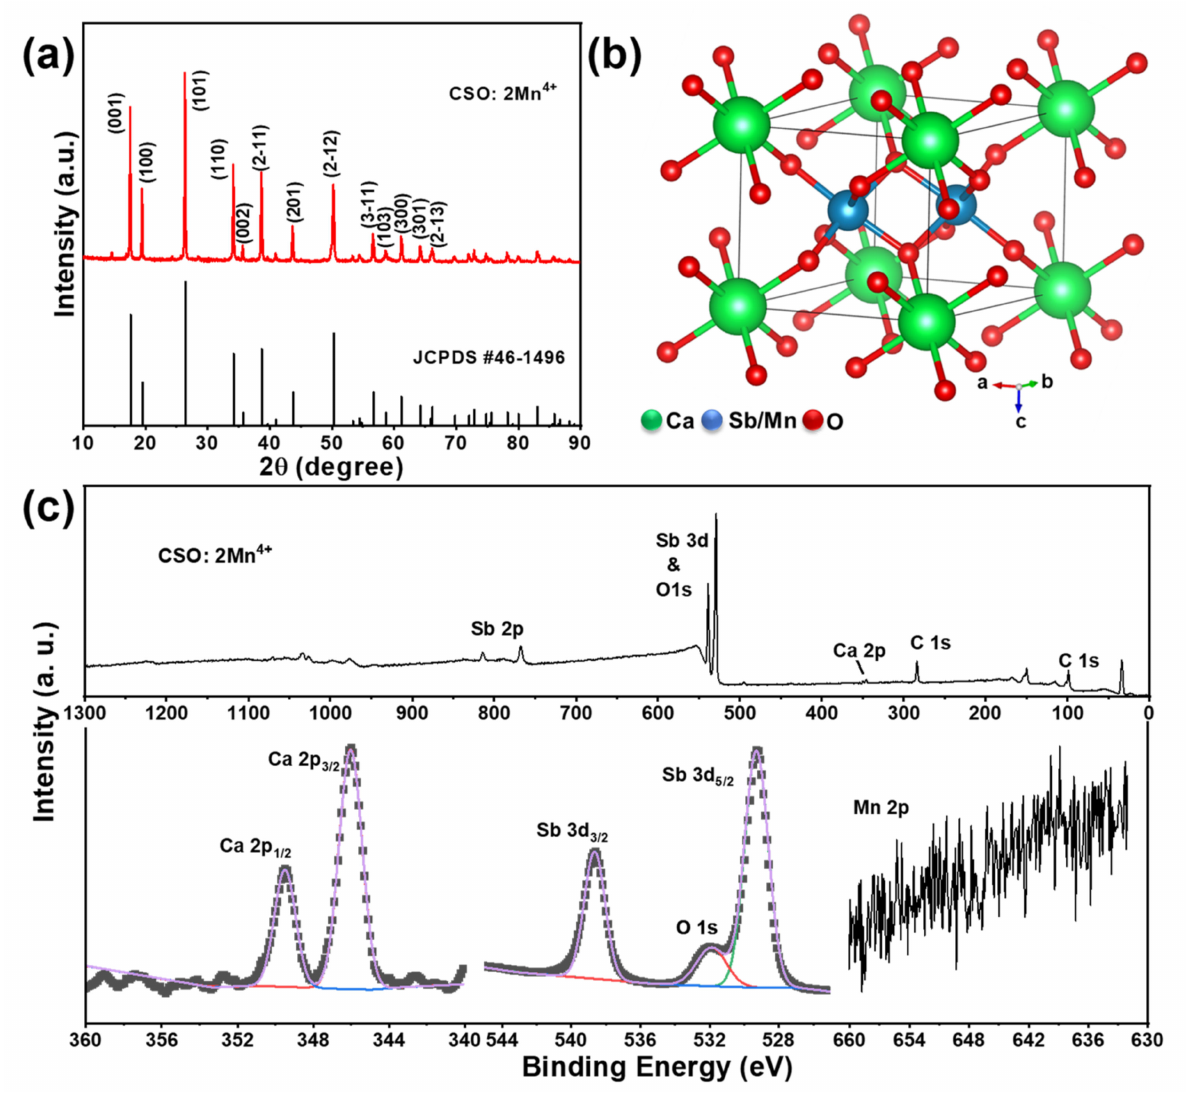
Figure 2. ( a ) XRD spectrum, ( b ) crystal structure, and ( c ) XPS results of CSO: 2Mn 4+ . The room temperature photoluminescence excitation (PLE) spectrum of the CSO: 2Mn 4+ is shown in Figure